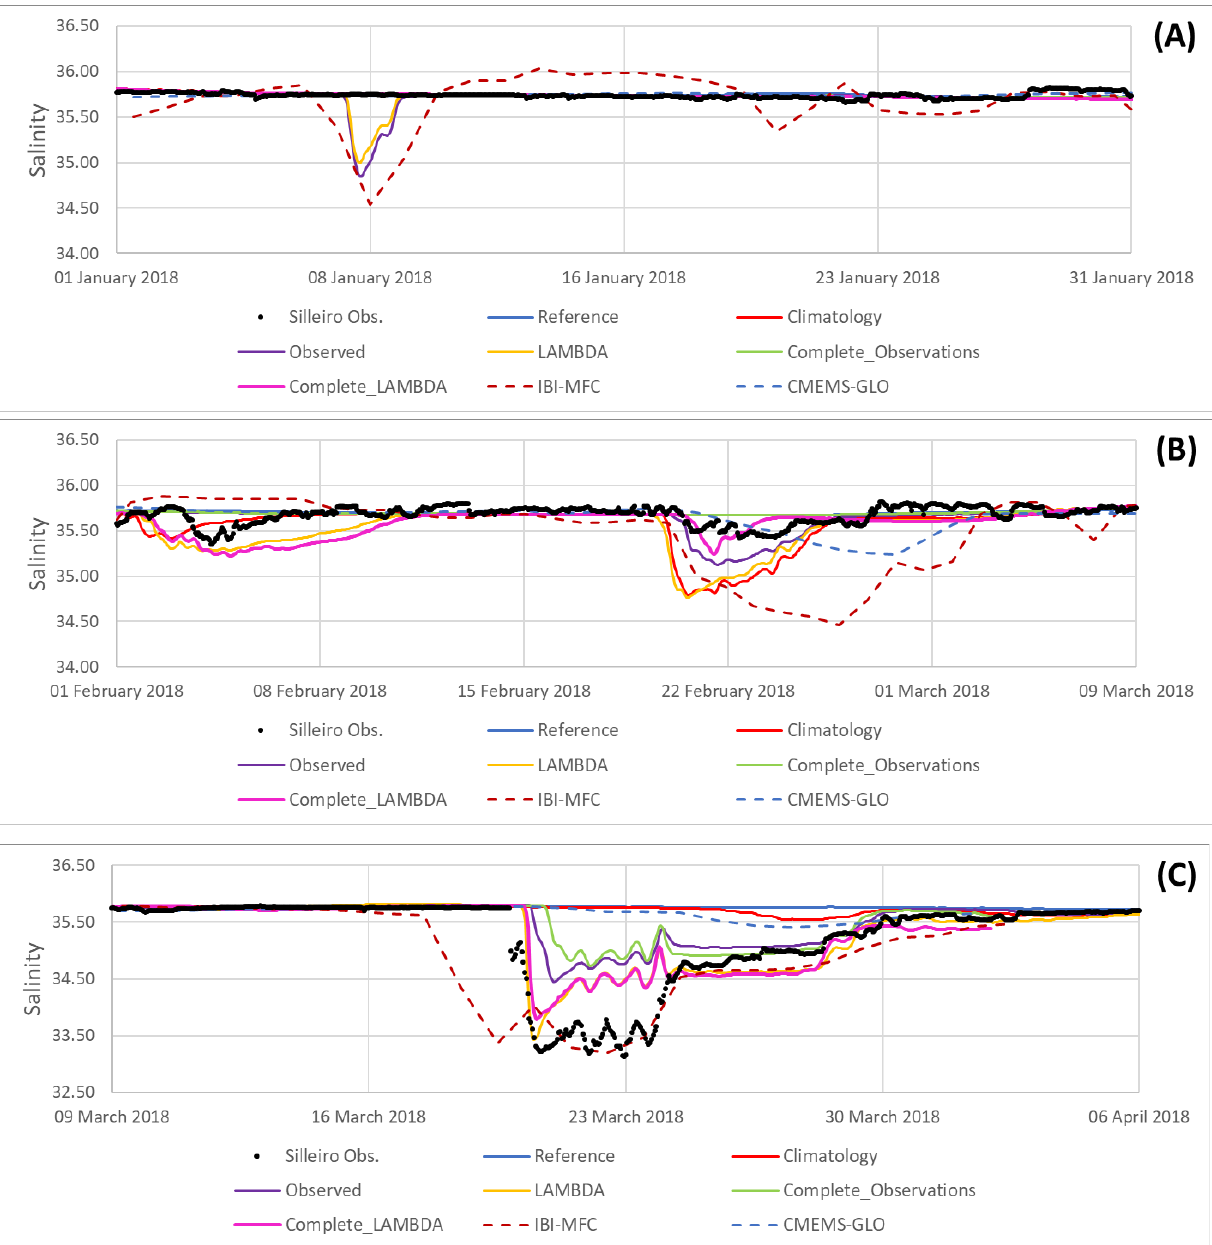
Figure 7. Sea surface salinity observed (black dots) and modelled at Silleiro buoy during the first quarter of 2018. PCOMS modelling scenarios include: no discharge simulations (Reference, Blue line), with direct discharge (Climatology (red line), Observed (purple line), and LAMBDA (yellow line)) as well as with the proxy for the main six estuaries plus 45 direct discharges (Complete Observations (green line) and Complete LAMBDA (pink line)). Surface salinity from CMEMS-Global (dashed red line) and IBI-MFC (dashed blue line) regional product are also included. The analysed was divided into three sections ( A ) (January), ( B ) (February and first week of March), and ( C ) (rest of March and first week of April) for clarity. See Section 3.3 for more configuration details.